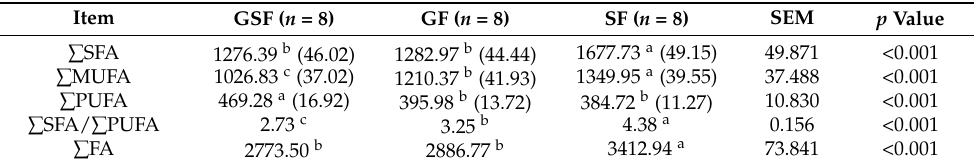
Table 3. Effect of feeding system on muscle fatty acid content (mg/100 g of meat) and composition (proportion × 100) in the LD muscle of Tan